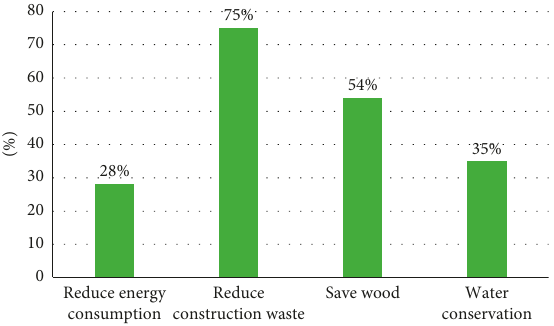
Figure 1: Environmental benefits of assembled